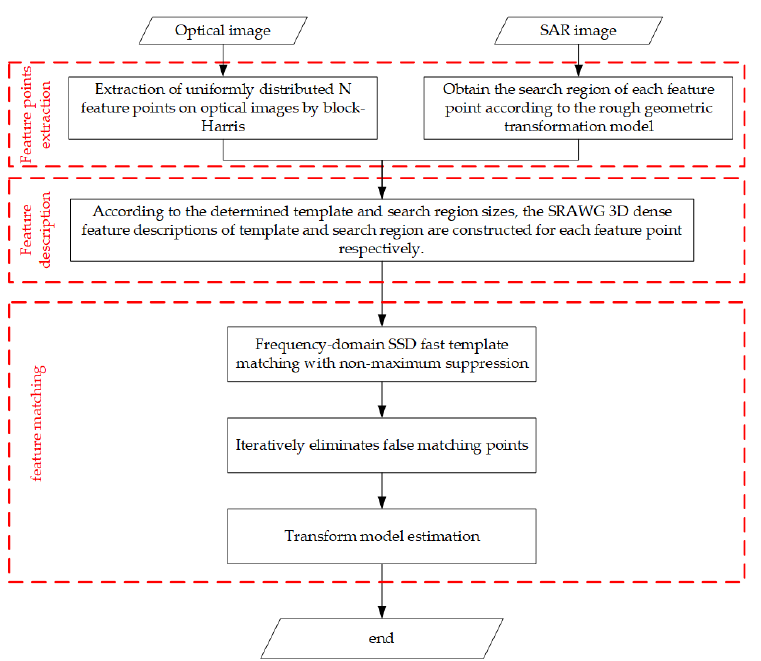
Figure 1. The flow chart of the proposed fast registration method.